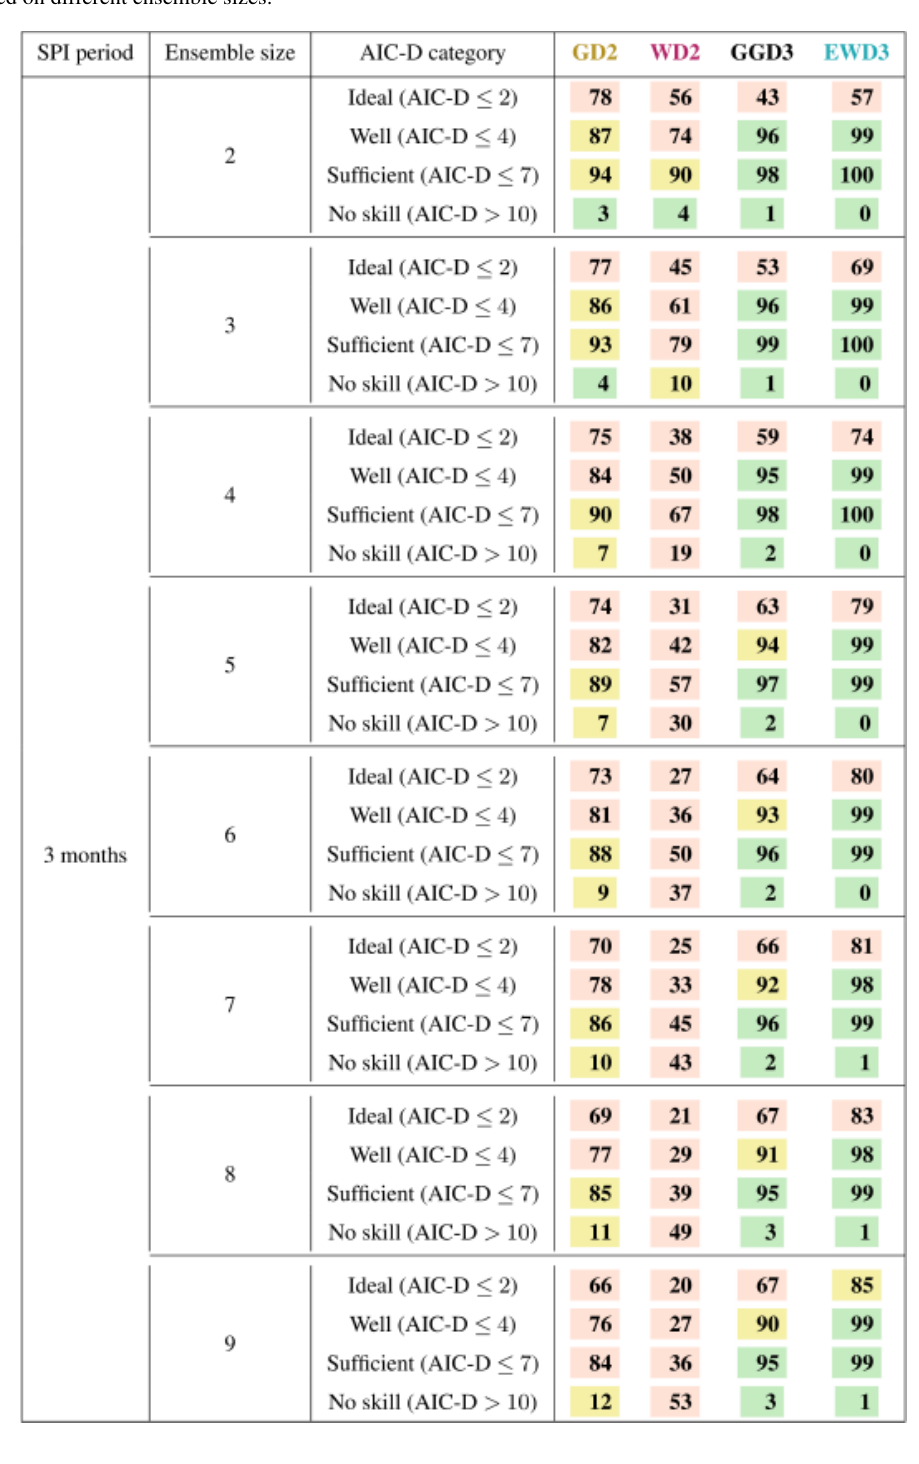
Table 5. Percent of grid points that are classified into specific AIC-D categories (according to Burnham and Anderson, 2002) for each candidate PDF over both seasons. Percentages of grid points indicate the confidence in candidate PDFs to overall performance according to the respective AIC-D category. We consider percentages that exceed (subceed in case of AIC-D values beyond 10) 95% (5%) as a sign of substantial confidence in the candidate PDF (green) to overall performance according to the respective AIC-D category. In contrast, we consider those candidate PDFs that exceed (subceed) in 85% (15%) of the grid points as a sign of average confidence in the candidate PDF (yellow) to overall performance according to the respective AIC-D category. Percentages that fall short of 85% (or that show no skill in more than 15%) are considered as an overall sign of insufficient confidence in the candidate PDF (red). In contrast to Table 3, the evaluation of simulations is based on different ensemble